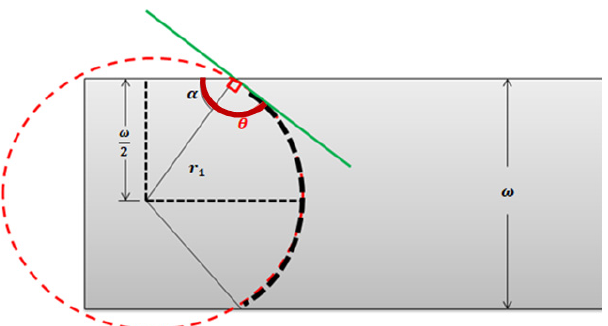
Figure A2. Top view of the contact angle of a fluid–air interface inside a microfluidic channel of width ω and height b.